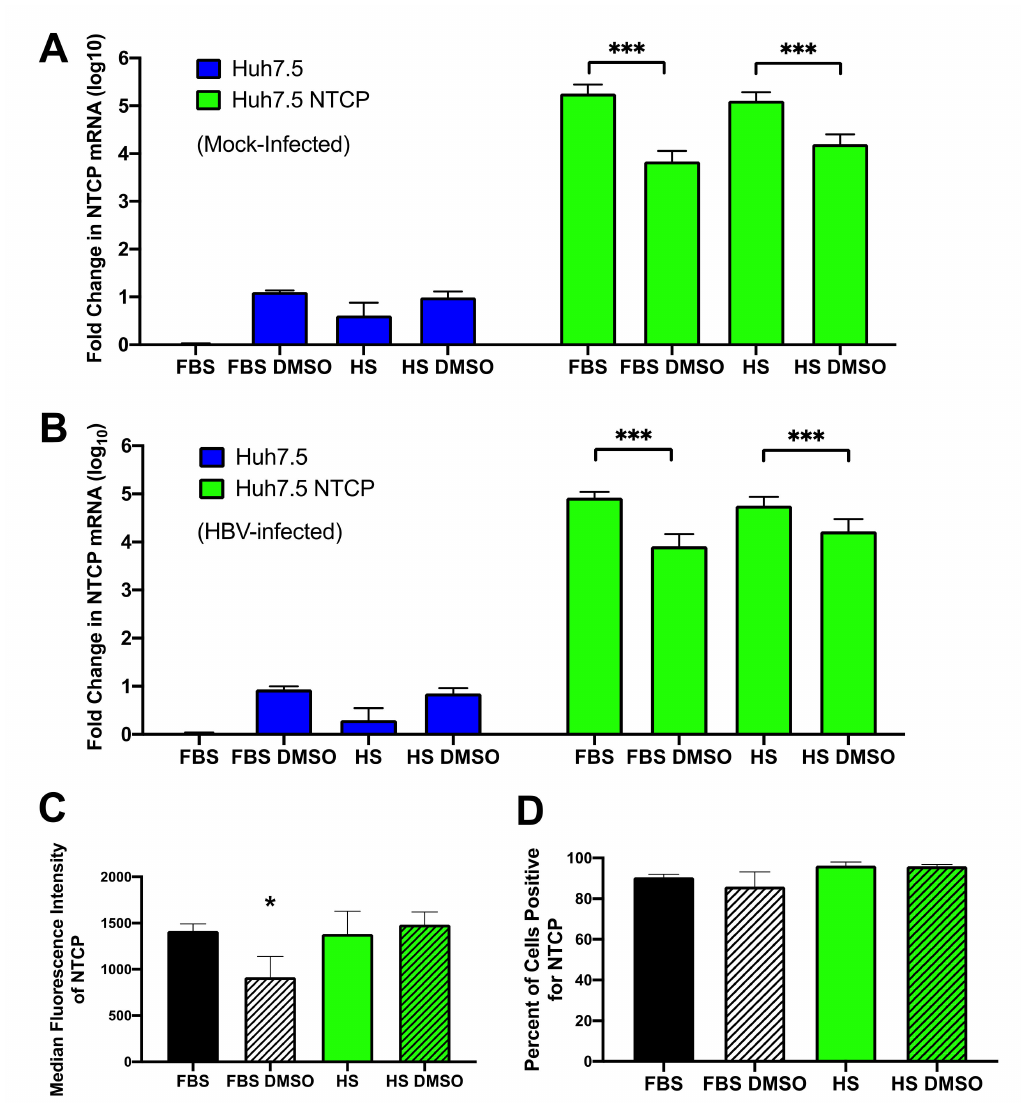
Figure 6. Changes in NTCP mRNA levels and surface NTCP protein expression under various culture conditions. Huh7.5 or Huh7.5-NTCP cells were ( A ) not infected with the virus (mock), or ( B ) infected with HBV. Samples were collected on day 7 post-infection for RT-qPCR analyses of NTCP mRNA and HPRT mRNA levels. ∆∆ CT values were calculated to determine fold changes in NTCP mRNA expression normalized to that of the Huh7.5 cells cultured in the medium containing FBS. Huh7.5-NTCP cells were analyzed with flow cytometry to assess ( C ) cell surface expression of NTCP based on median fluorescence intensity and ( D ) the percentage of cells expressing NTCP. Average values with error bars ( ± SD) derived from three independent experiments are plotted. One-way analysis of variance (ANOVA) was used with the Bonferroni correction for multiple comparison test. * p < 0.05; *** p <